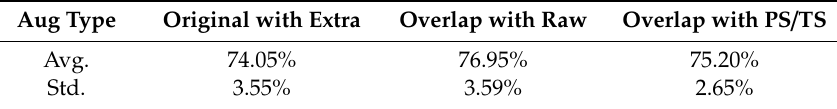
Table 9. Test accuracy of augments applied in partial pre-pertained network.